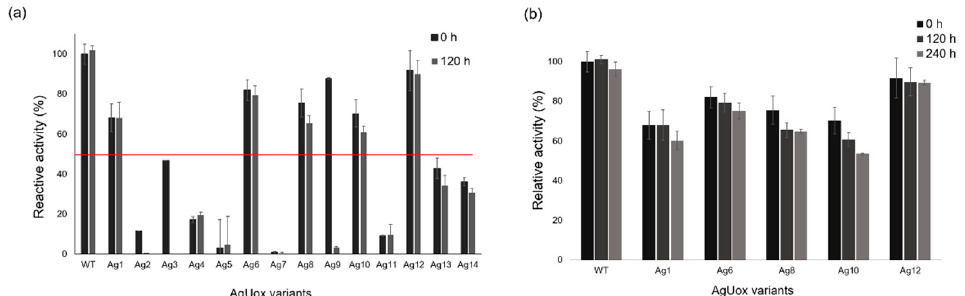
Figure 3. Thermostability assessment of AgUox-WT and AgUox-frTet variants. ( a ) Relative enzyme activity of AgUox-WT and AgUox-frTet (Ag1–14) variants in PBS monitored at 0 and 120 h. Red line indicates the 50% enzymatic activity of AgUox-WT. ( b ) Relative enzymatic activity of AgUox-WT and five AgUox-frTet variants (Ag1, 6, 8, 10, and 12) monitored at 0, 120, and 240 h. The relative activity of AgUox-frTet variants was normalized against the enzymatic activity of AgUox-WT.